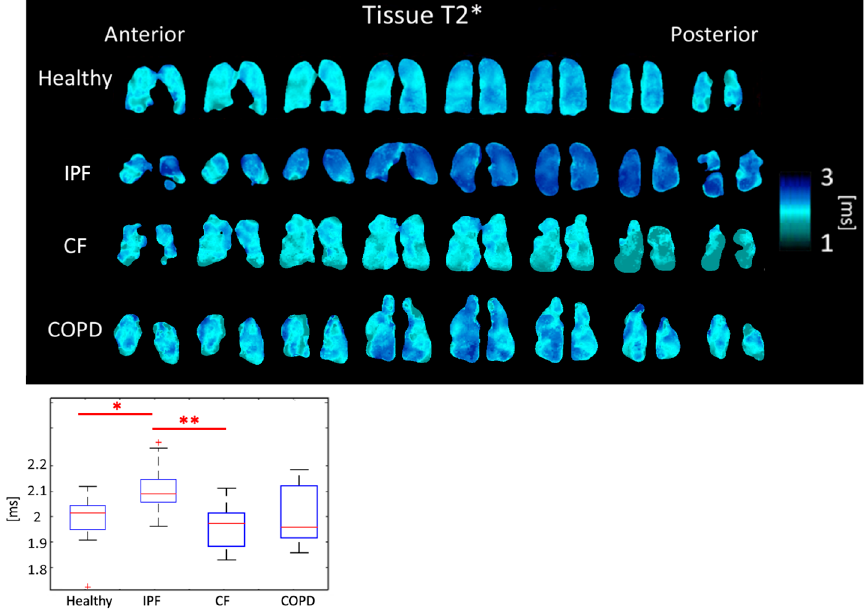
Figure 6. Tissue T2* maps ( top ) and boxplots ( bottom ) for each disease type. ( p < 0.01 = **, p < 0.5 = *, + outlier).